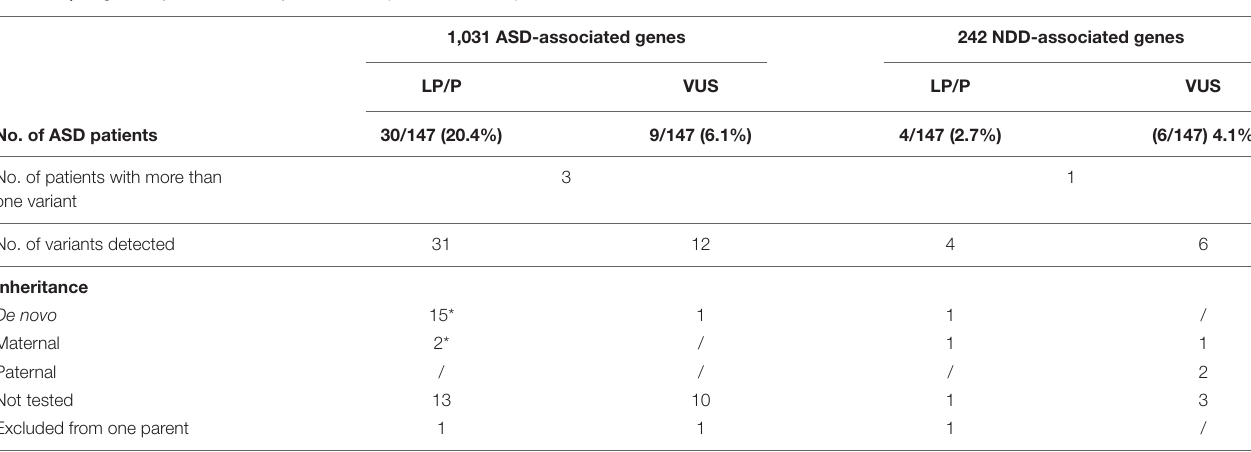
TABLE 1 | Diagnostic yield obtained by WES in 147 patients with suspected